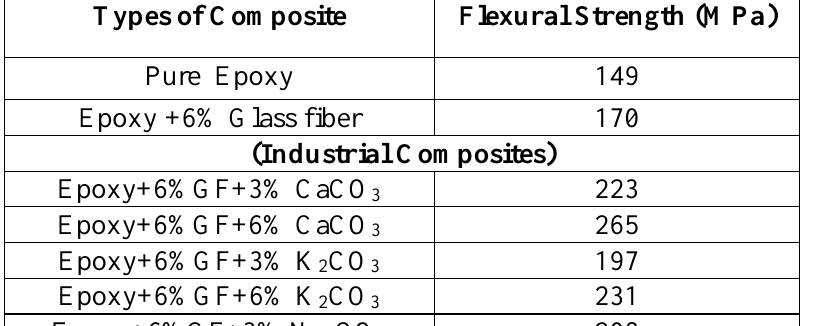
Table 5: Flexural strength of the prepared composites.